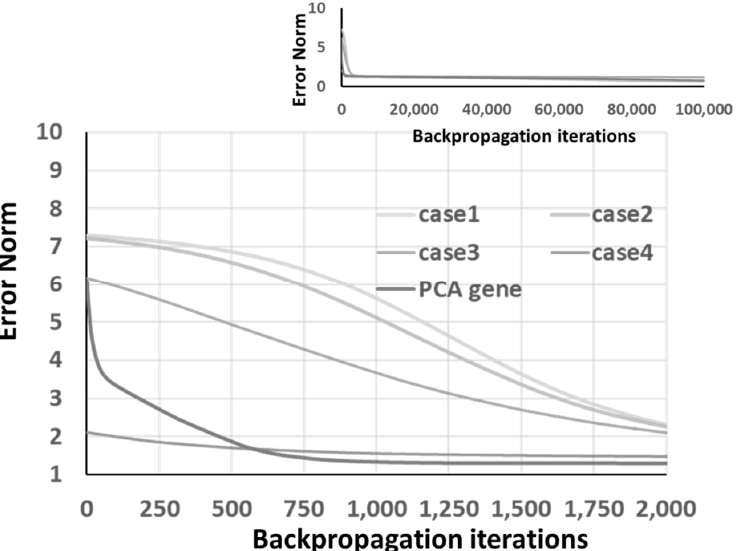
Figure 18. The convergence of 4 GA “progressing” optimized chromosomes and PCA gene under ANN architecture. ANN